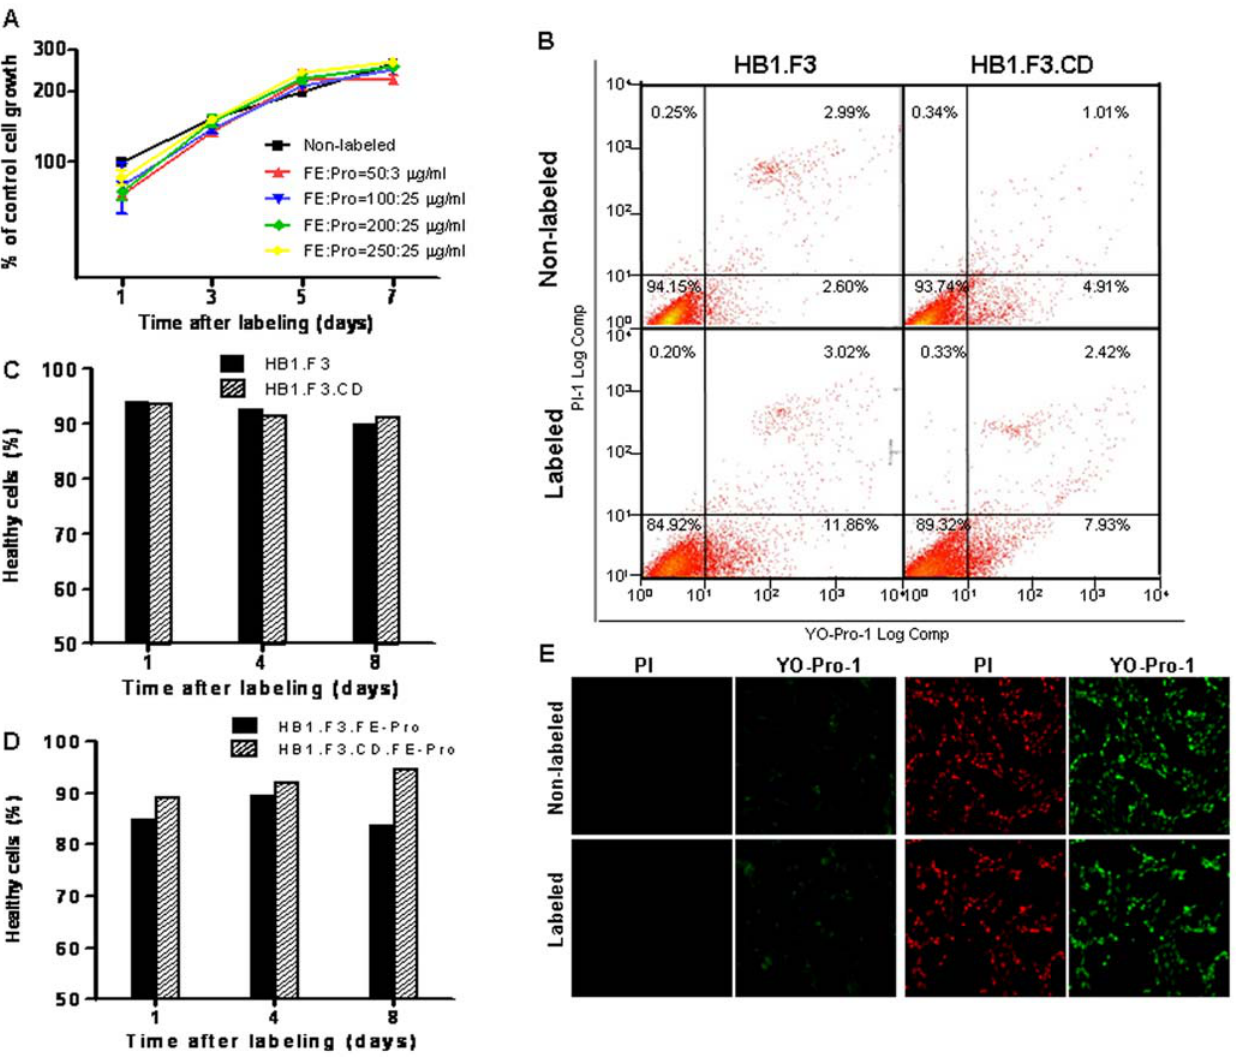
Figure 1. Cellular viability of FE-Pro-labeled NSCs. (A) Cellular biomass normalized to non-labeled NSC cell growth at day 1 as measured by absorbance of protein-bound sulforhodamine B (SRB) at 570 nm. Data are mean 6 SE of triplicate samples and were analyzed using paired t-test between non-labeled vs. each FE-Pro dosage. P , 0.05 was considered statistically significant. (B) Representative FACS plots showing the viable and apoptotic cell populations at 24 hours post-label and before sub-culturing. (C–D) Bar graphs showing the percentage of healthy cells at days 1, 4 and 8 for non-labeled NSCs (C) , and FE-Pro-labeled NSCs (D) after sub-culturing passage at each time point. (E) : Confocal images of healthy FE-Pro labeled and non-labeled NSCs (left panel) and apoptosis-induced FE-Pro labeled and non-labeled NSCs (right panel) at Day 6 post-labeling. Staining: PI (red), YO-Pro-1 (green). A FE-Pro dosage of 50:3 m g/ml was used for each labeled sample unless otherwise indicated. Abbreviations: FE-Pro, Ferumoxide-Protamine Sulfate complex; PI, propidium iodide; Magnification: 20 6 .